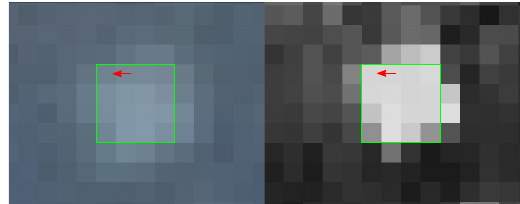
Figure 17. Manual selection of road marking's corner point for result evaluation.